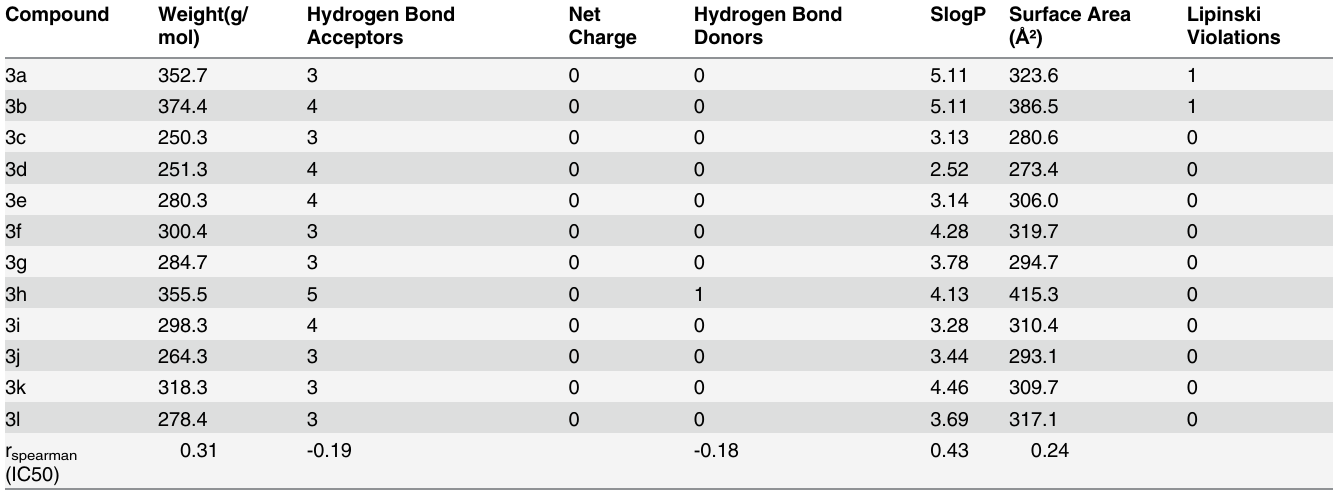
Table 2. Structure-activity relationships of newly synthesized tri-substituted-condensed-imidazopyridines. Compound